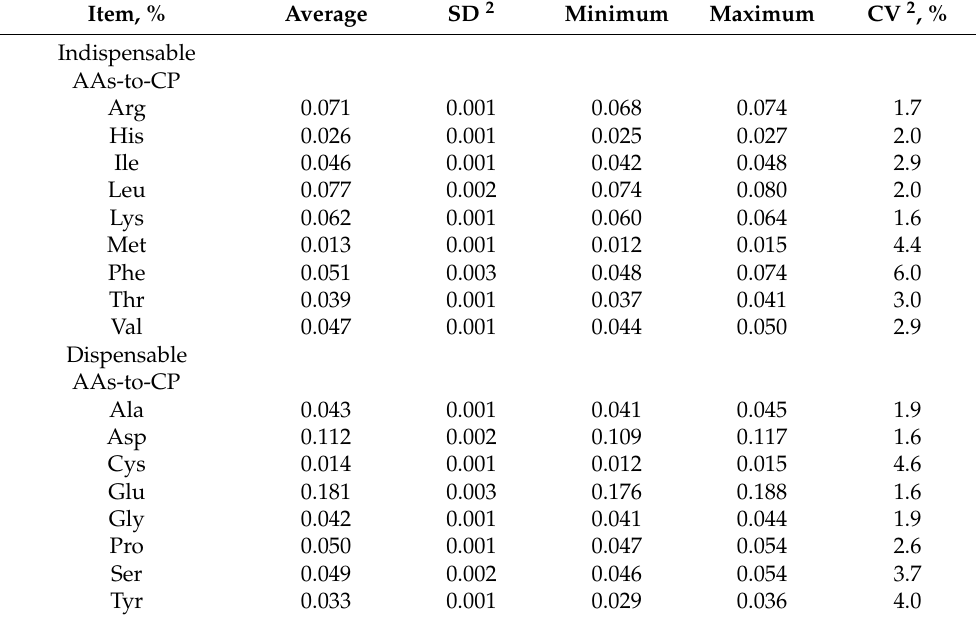
Table 2. Amino acid (AA)-to-crude protein (CP) ratio in soybean meal 1